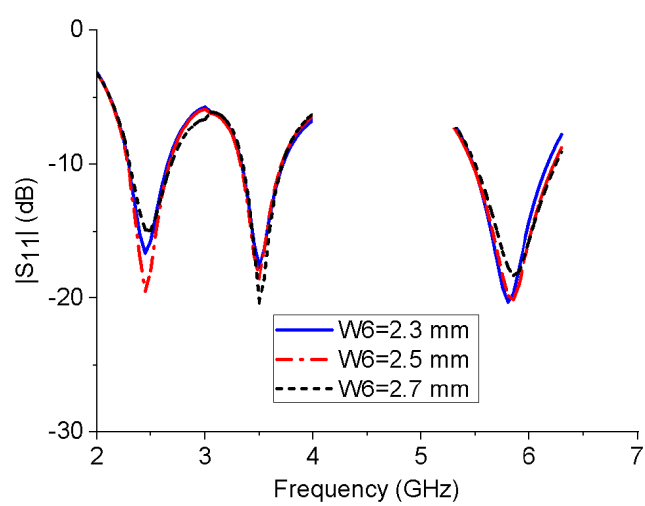
Figure 6. Reflection coefficients of the monopole antenna with different W6 values.